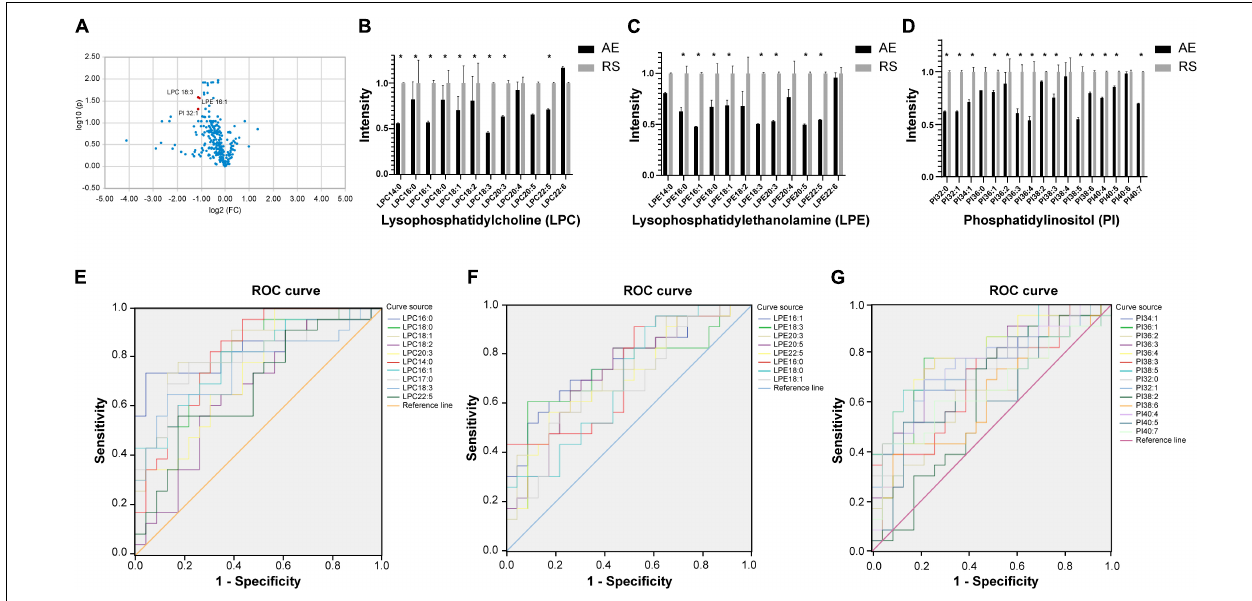
FIGURE 2 | (A) Volcano plot showing glycerophospholipids with significant differences between the AE and recovery stages of COPD. The x -axis is the logarithm to the base 2 of the ratio of a given phospholipid in the AE and recovery stages, and the y -axis is the logarithm to the base 10 of the P -value of that phospholipid in different subgroups. The phospholipids that showed significant changes were LPC 18:3, LPE 16:1, and PI 32:1. (B–D) Histograms showing all LPC, LPE, and PI in the metabolic profiles between the AE and recovery stages (* P < 0.05). AE, acute exacerbation; RS, recovery stage. (E–G) ROC curve analysis of the main differential glycerophospholipids during COPD recovery (LPC, LPE, and PI). ROC curve analysis was performed using the main differential glycerophospholipids above as the test variables and the recovery phase as the state variable. The areas under the curve (AUCs) for LPC 14:0, 16:0, LPC 16:1, LPC 17:0, LPC 18:0, LPC 18:1, LPC